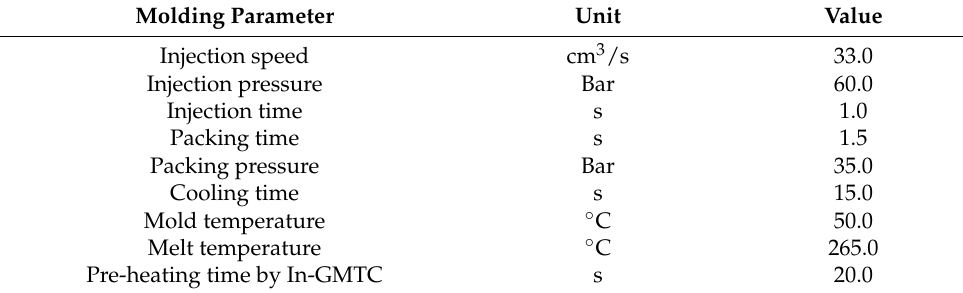
Figure 8. The sensor locations. Table 2. The molding parameters for the front cover plate product.